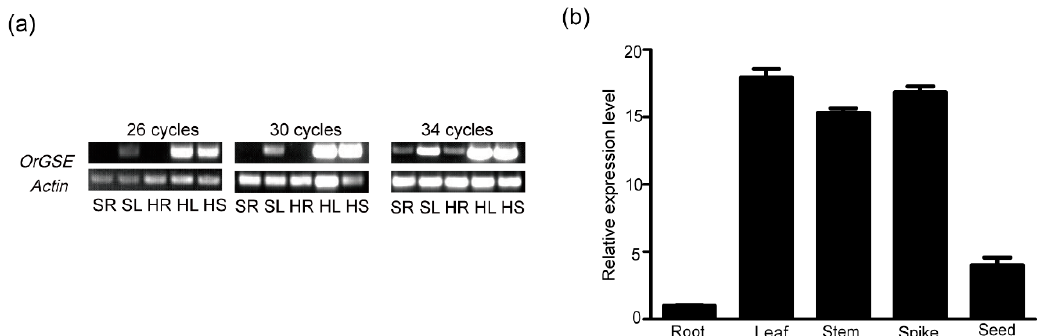
Figure 1. OrGSE gene expression in roots and shoots of common wild rice. The mRNA levels of OrGSE gene were determined in different tissues and developmental stages by RT-PCR with 26, 30 and 34 cycles of amplification. ( a ) The gel figure of RT-PCR. The rice Actin gene was used as an